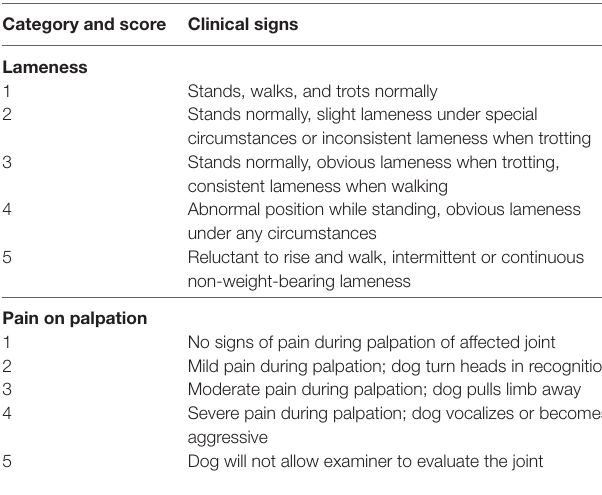
category and score clinical